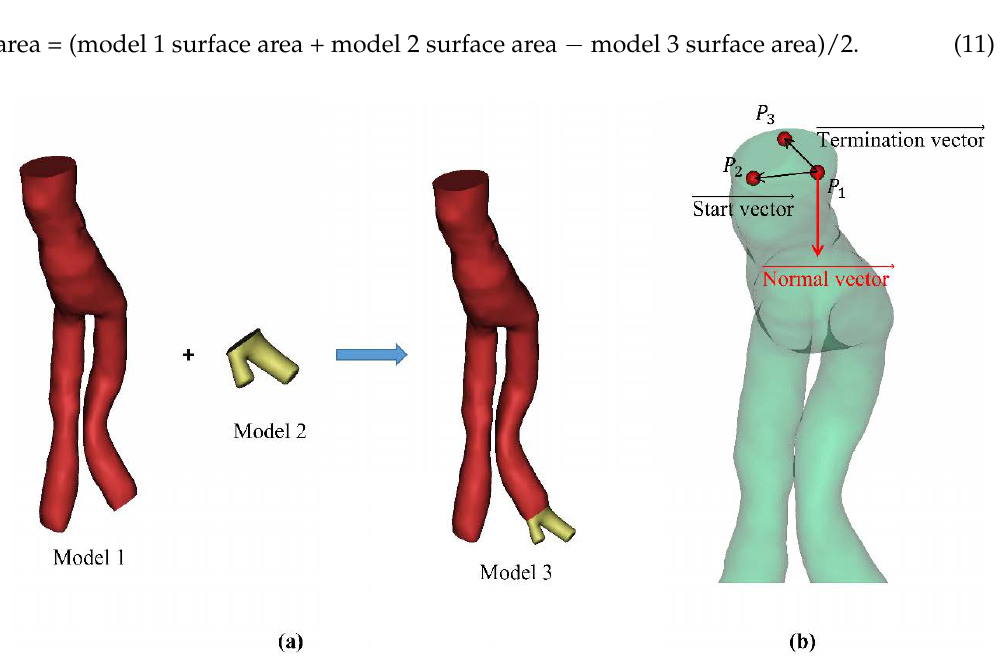
Figure 3. ( a ) Schematic diagram of section area measurement method. ( b ) Schematic diagram of the angle measurement method. The normal direction was always toward the inside of the stent graft.